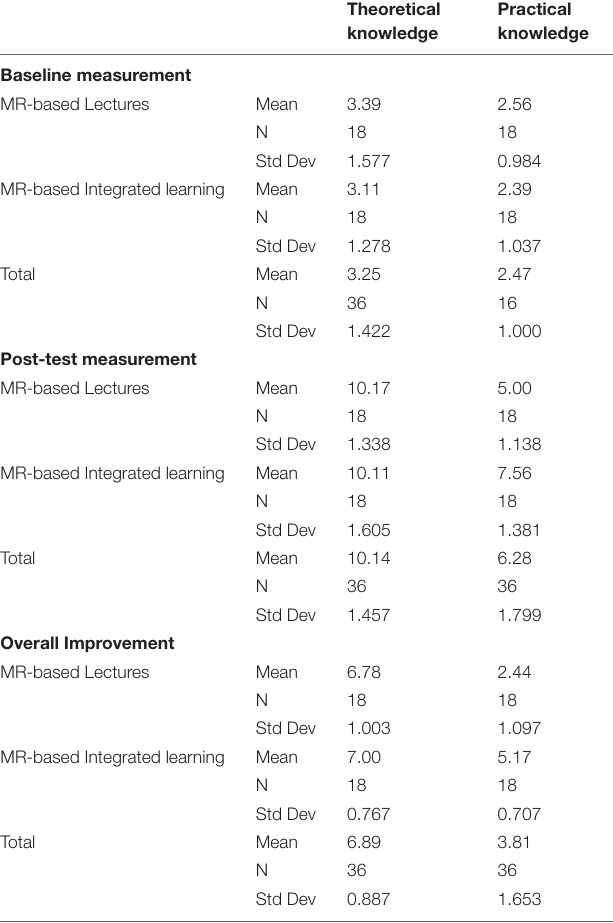
TABLE 8 | Summary of comparative analysis of the learning